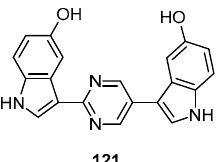
Figure 30. Chemical structure of hyrtinadine A ( 121 ).